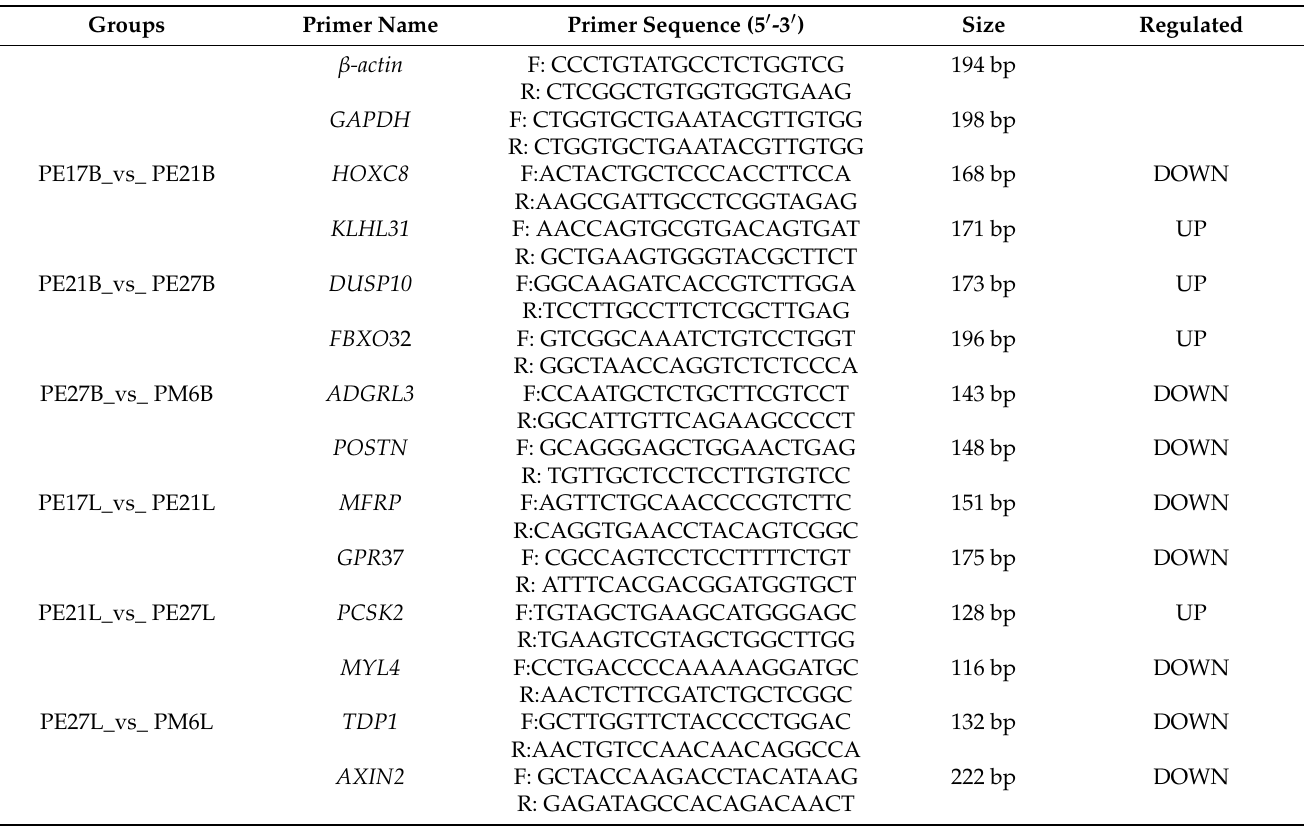
Table 1. Primer sequences for qPCR validation and